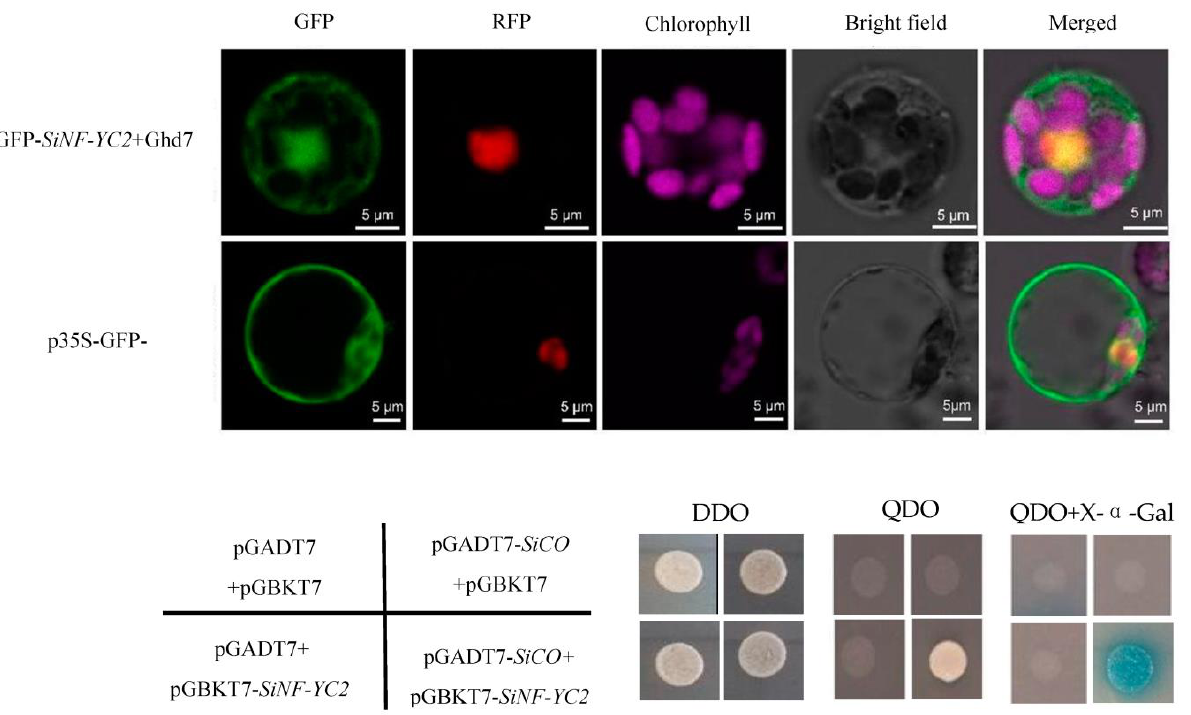
Figure 4. SiNF-YC2 and SiCO interact in the nucleus. ( a ) Subcellular localization of SiNF-YC2 protein. ( b ) Interaction of SiNF-YC2 and SiCO . DDO: two-deficient SD/-Leu-Trp medium; QDO: four-deficient SD/-Ade-His-Leu-Trp medium.